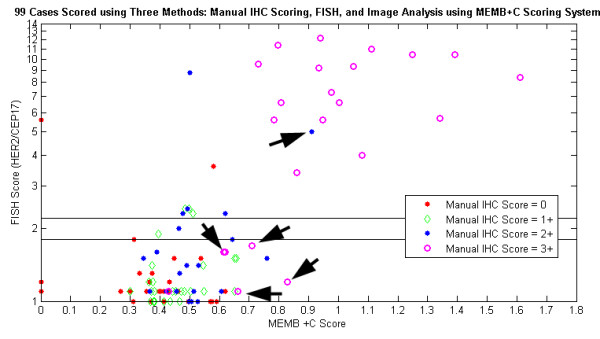
Simultaneous view of three scoring methods: Mn, FISH, and Manual. Plot of mean intensity of stained membrane regions normalized by control (Mn) versus genetic amplification (FISH). Different colors denote manual scores. Arrows depict example cases whose classification was enhanced due to image-based analysis.